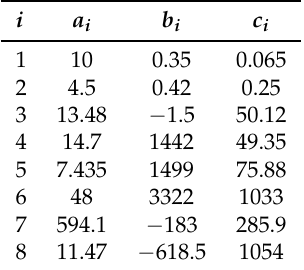
Table 1. The a i , b i and c i